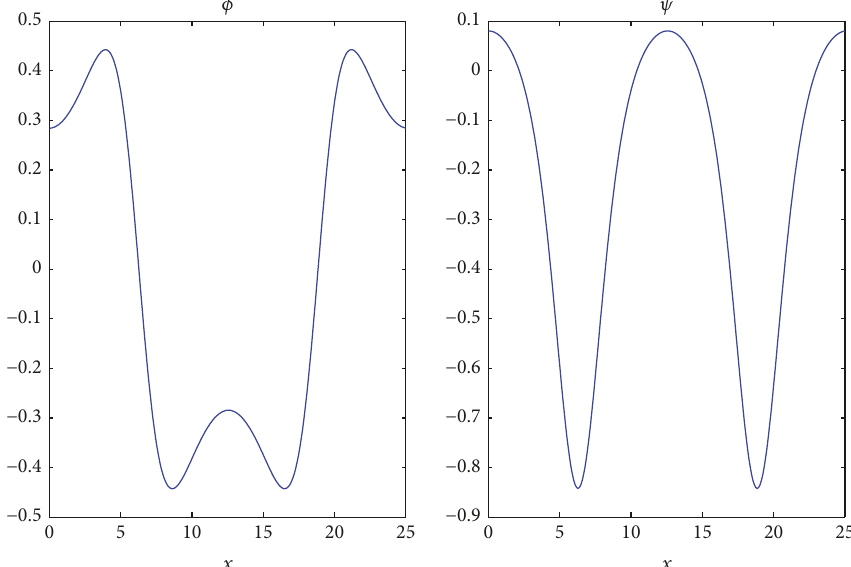
resulting fundamental period of the travelling wave is 𝐿 = 4𝜋/𝑐 ≈ 6.28 . We point out that, in this numerical simulation, the travelling wave is faster ( 𝑐 = 2 ) than the one computed in the previous numerical experiment ( 𝑐 = 1.5